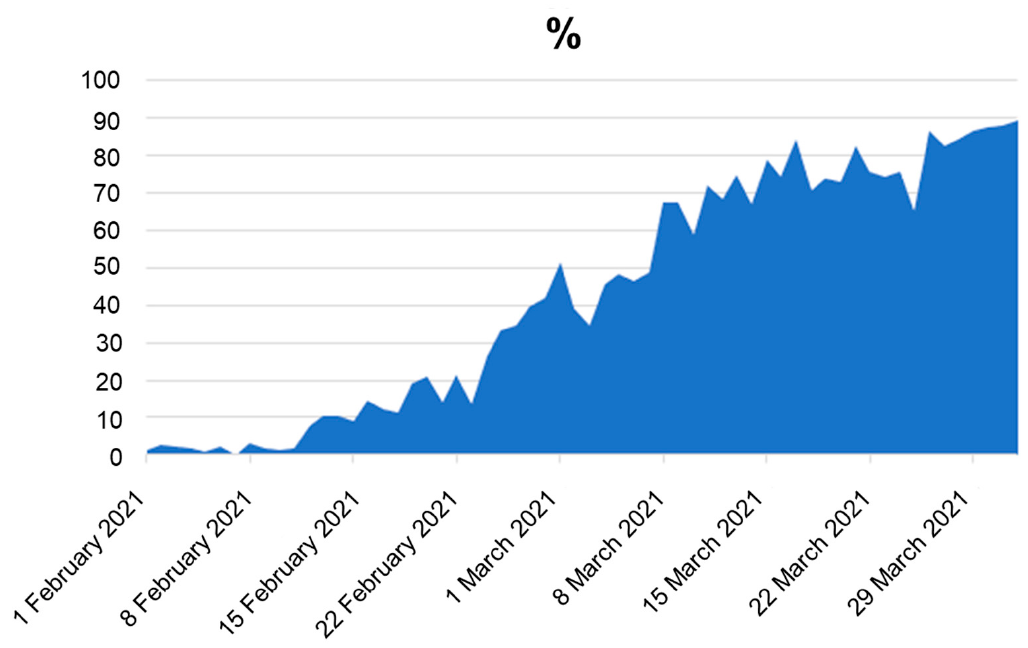
Figure A2. S-dropout due to H69-70del in the Alpha variant.